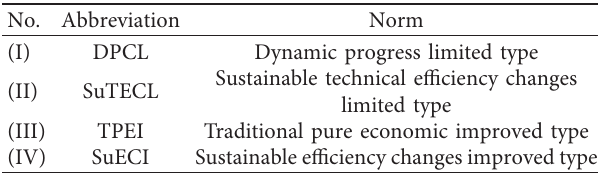
Table 3: Four type of performance of Chinese rural